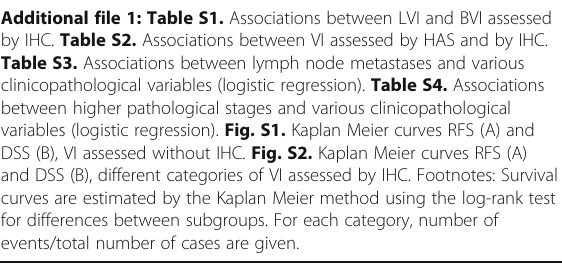
Table S3. Associations between lymph node metastases and various clinicopathological variables (logistic regression). Table S4. Associations between higher pathological stages and various clinicopathological variables (logistic regression). Fig. S1. Kaplan Meier curves RFS (A) and DSS (B), VI assessed without IHC. Fig. S2. Kaplan Meier curves RFS (A) and DSS (B), different categories of VI assessed by IHC. Footnotes: Survival curves are estimated by the Kaplan Meier method using the log-rank test for differences between subgroups. For each category, number